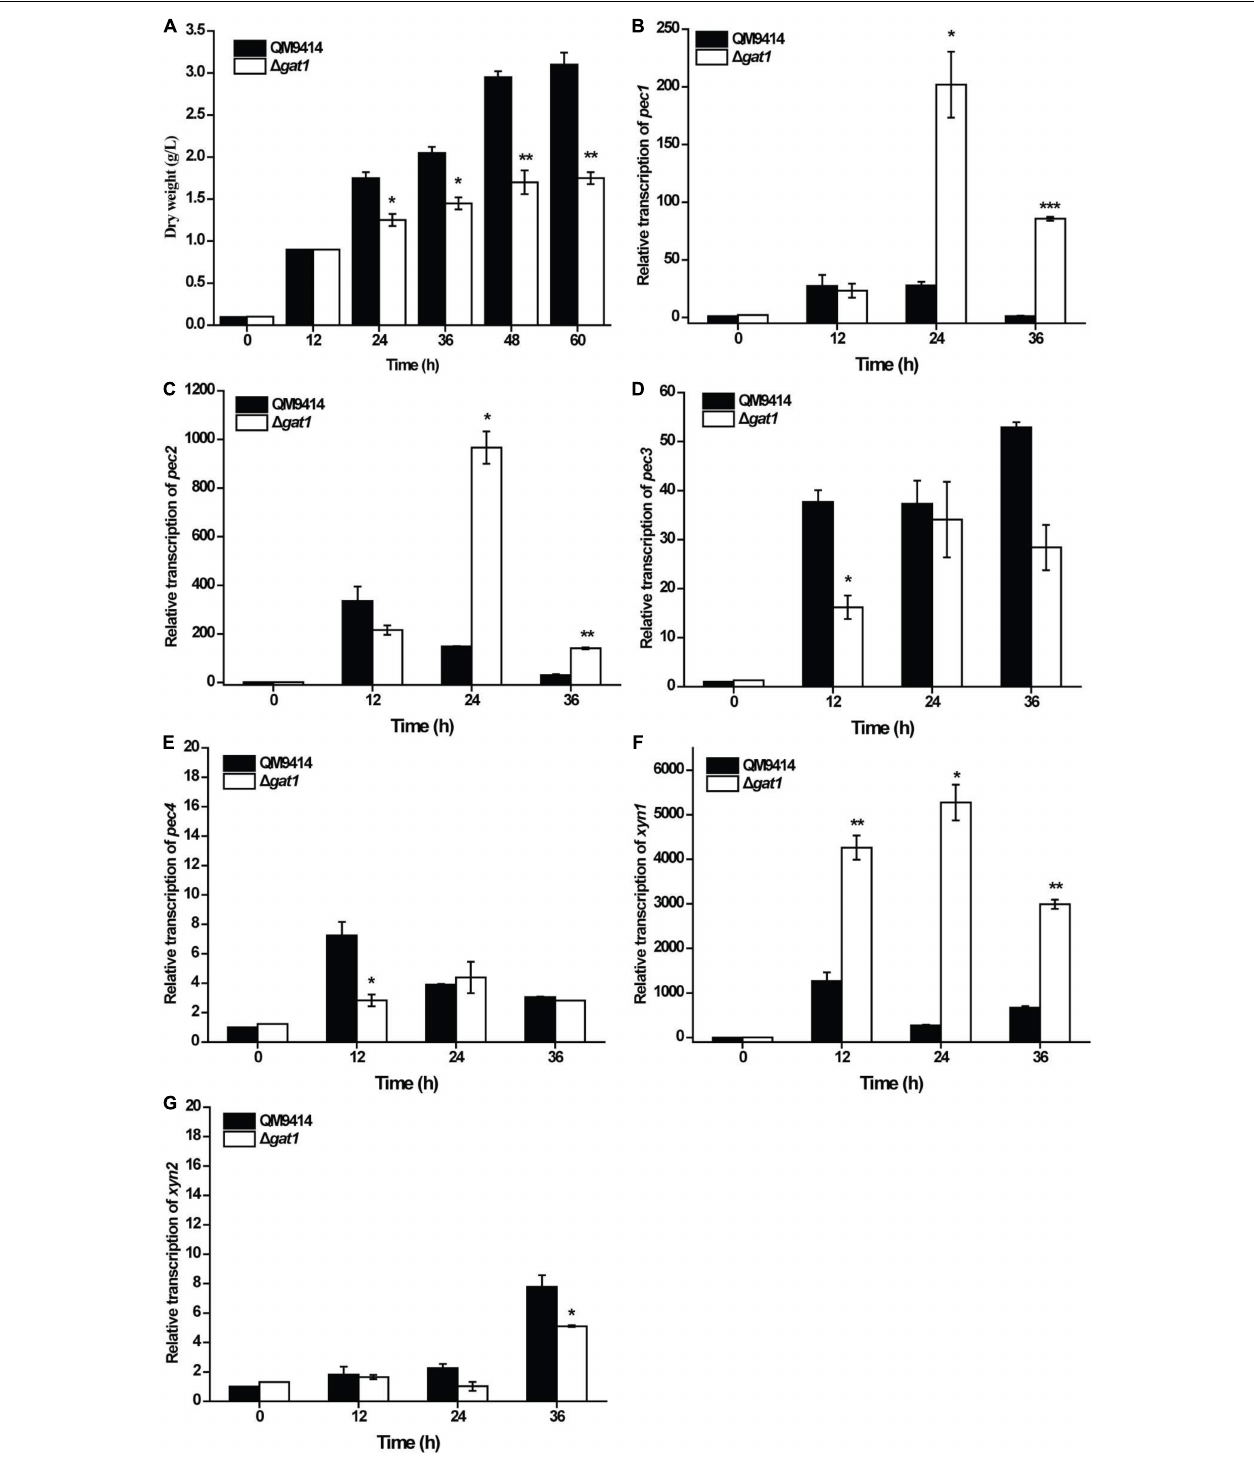
FIGURE 5 | Deletion of gat1 affected the expression of both pectinase genes xylanase genes upon galacturonic acid. (A) Growth analyses of QM9414 and (cid:49) gat1 with 0.5% (w/v) galacturonic acid as the sole carbon source. (B–F) Quantitative RT-PCR analyses of the relative transcriptional levels of pec1 (B) , pec2 (C) , pec3 (D) , pec4 (E) , xyn1 (F) and xyn2 (G) in QM9414 and (cid:49) gat1 cultivated with 0.5% (w/v) galacturonic acid as the sole carbon source. Values in this figure are the mean of three biological replicates. Error bars are the SD from these replicates. Significant differences ( t -test, * P < 0.05, ** P < 0.01, and *** P < 0.001) were detected in the biomass accumulation and relative transcription of the above genes between QM9414 and (cid:49) gat1 .